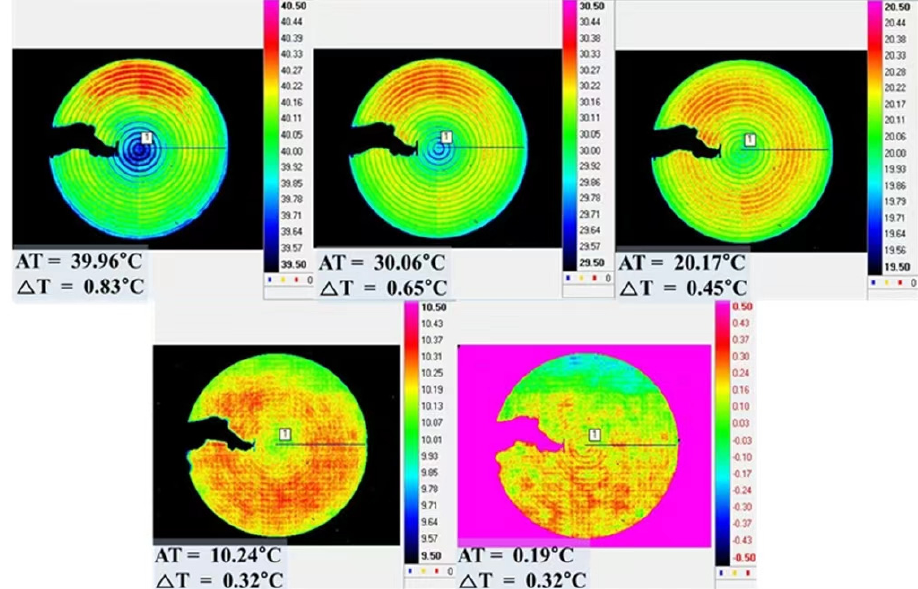
Figure 15. Temperature distribution on BB surface measured using IR camera; AT: average temperature of BB surface; ∆ T: temperature gradient on BB surface.